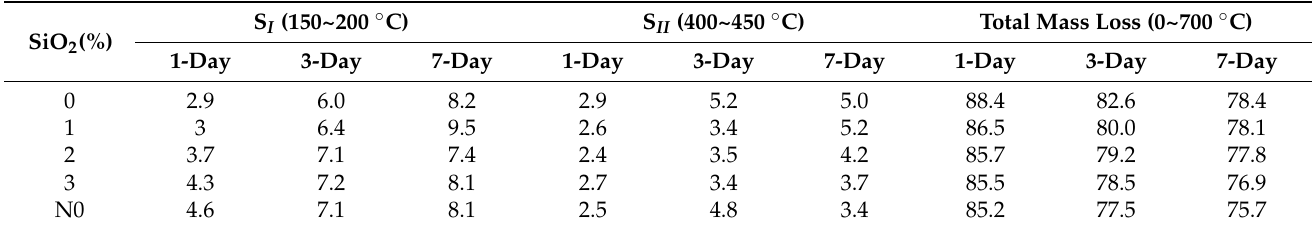
Table 5. The mass loss of the CRTS with different